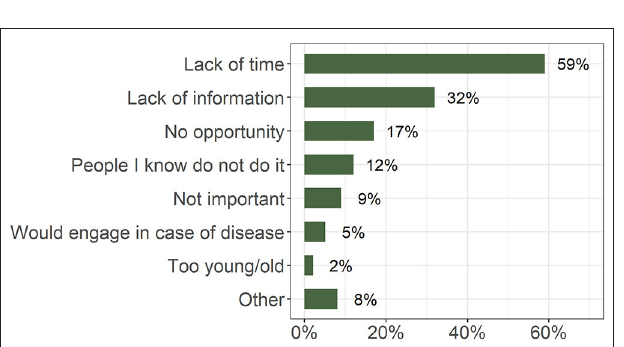
FIGURE 4 | Percentage of responses to the question “Among the following sources choose the first three that you rely most on to gain information about the brain” ( n =